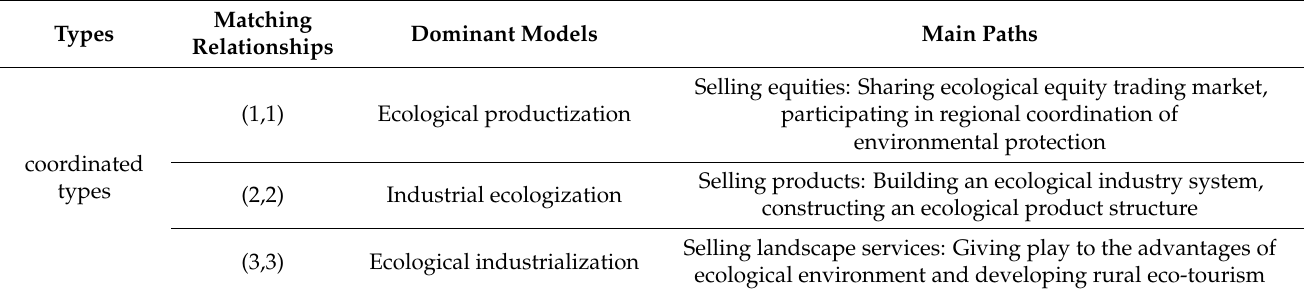
Table 2. Models and implementation paths of rural